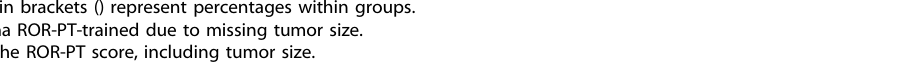
N = number of cases. Figures in brackets () represent percentages within groups. a 19 missing values for Prosigna ROR-PT-trained due to missing tumor size. b Prosigna-trained represents the ROR-PT score, including tumor